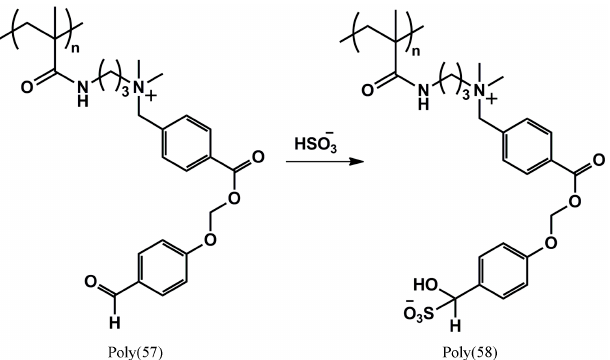
Figure 9. Reversible switch of poly(57) by addition of HSO 3 ´ ions